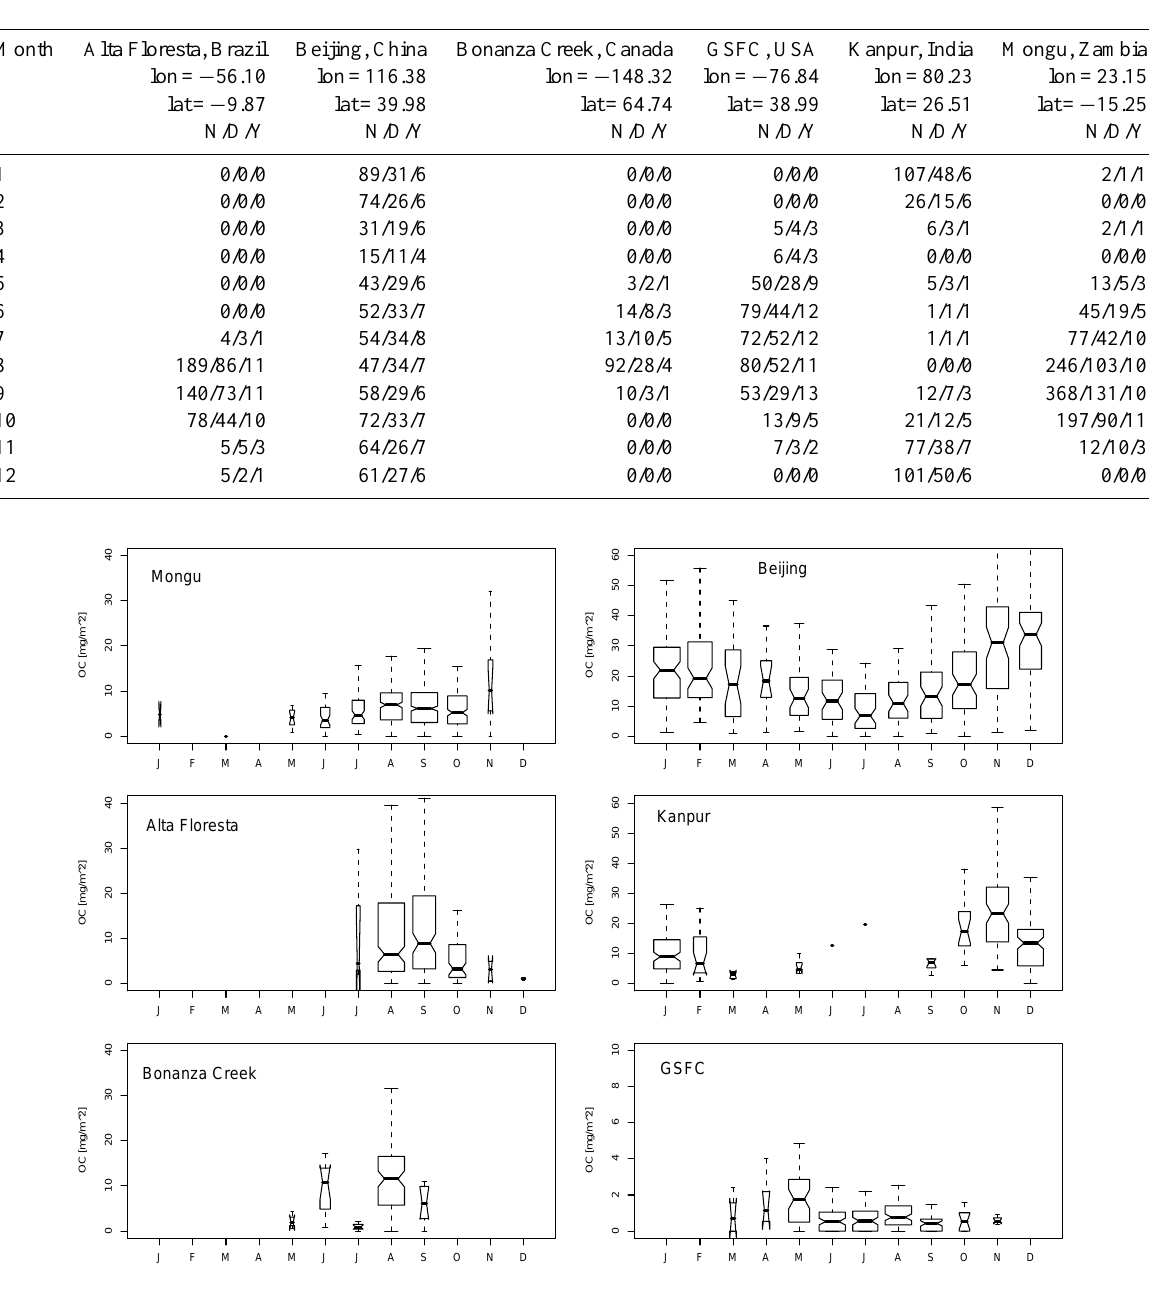
Fig. 3. Boxplot of monthly absorbing OC [mgm − 2 ] for the following sites: Mongu, Beijing, Alta Floresta, Kanpur, Bonanza Creek, and GSFC. Non-overlapping notches indicate that those medians are statistically different. The boxes are drawn with widths proportional to the square-roots of the number of observations in each